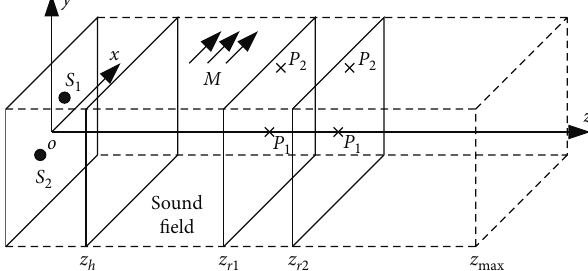
Figure 2: The geometry of the FDWTD